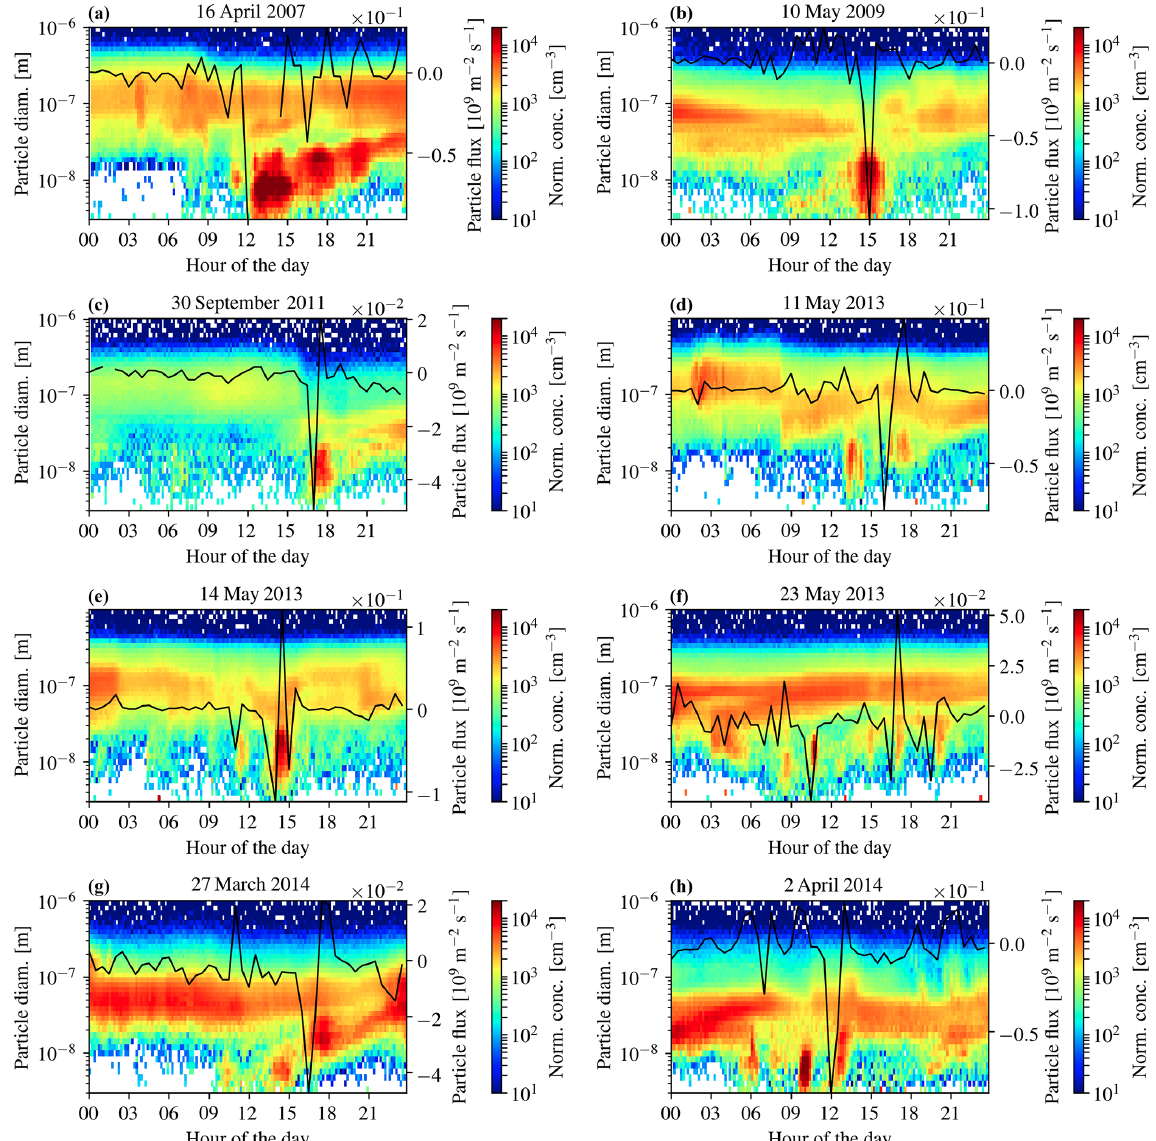
Figure 9. Panels (a–h) show 3–1000nm particle number-size distribution measured at the SMEAR II station by the DMPS during some of the days when there was roll-induced NPF. In addition, the black line shows the vertical flux of particles greater than 10nm measured at 23m